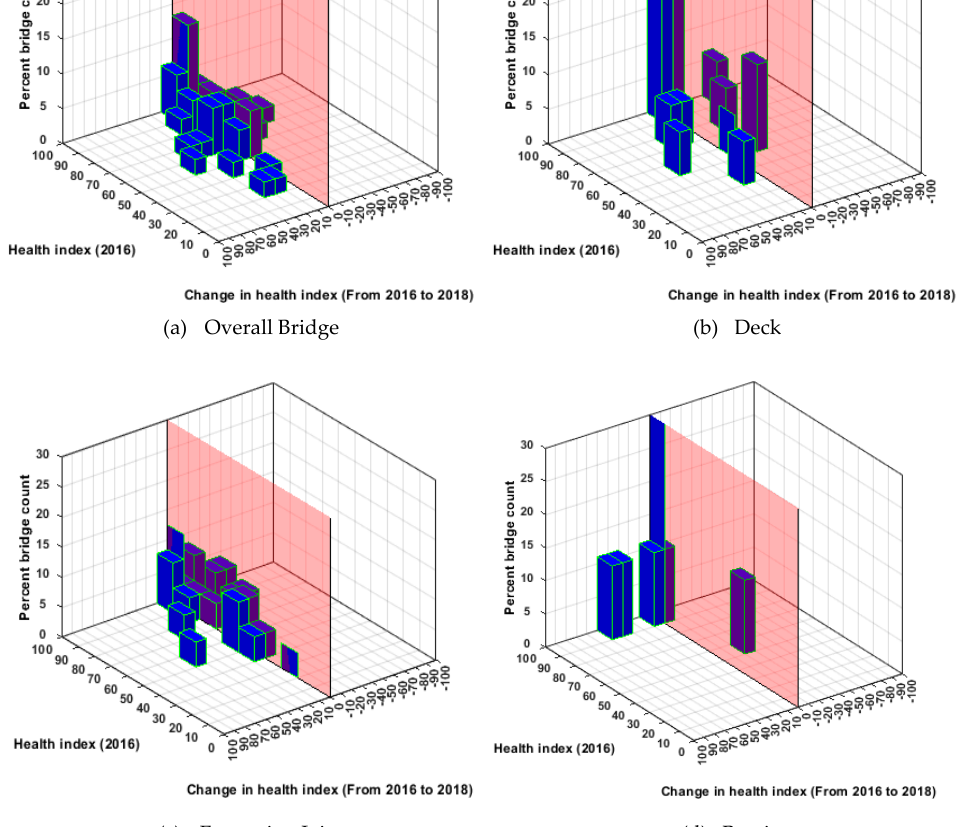
Figure 17. Non-NHS bridge performance in New York. ( a ) Overall bridge; ( b ) concrete deck; ( c ) expansion joint; ( d ) bearing.